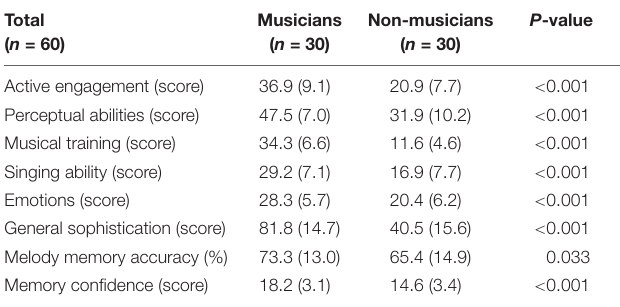
TABLE 3 | Musical abilities according to the Gold-MSI in both